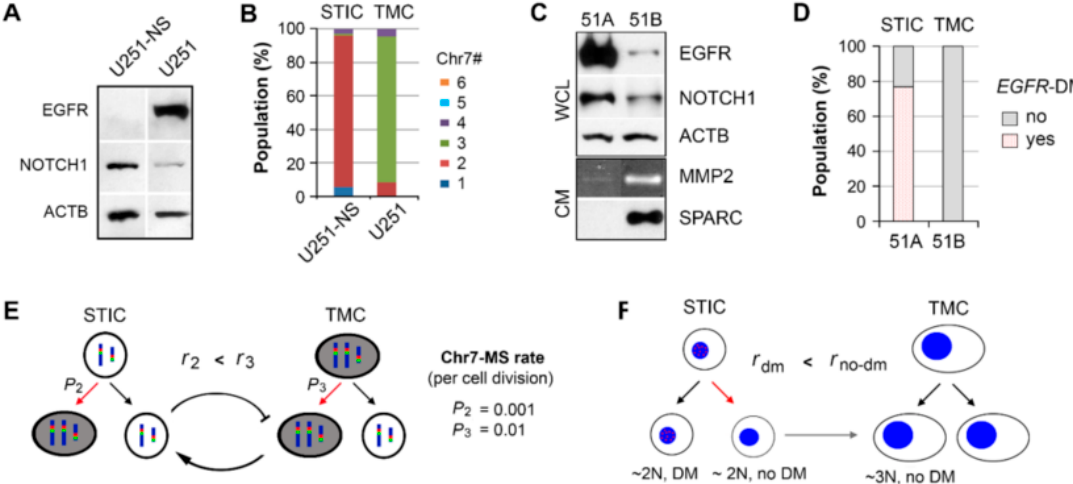
Figure 1. Two syngeneic glioma cell lines enriched with functional tumor subpopulations characterized as STIC and TMC. ( A ) Differential overexpression of oncogenic proteins in TMC-enriched U251 and STIC-enriched U251-NS, detected by immunoblotting. ( B ) Enrichment of two or three copies of Chr7 in U251-NS and U251, respectively. Copies of Chr7 were detected by FISH of the centromeric enumeration probe (CEP) 7. Colors represent the number of copies of Chr7 per cell as defined by the legend. ( C ) Differential overexpression of oncogenic proteins in STIC-enriched 51A and TMC-enriched 51B, detected by immunoblotting. EGFR, NOTCH1, and ACTB were measured from whole cell lysate (WCL), while MMP2 and SPARC were from conditioned media (CM) ( D ) Enrichment of cells with or without EGFR-containing DM in 51A and 51B, respectively, by FISH detection of EGFR by the EGFR-probe. ( E , F ) Depictions of the two tumor heterogeneity models. The above presentations were based on previously published work [10,11,15].